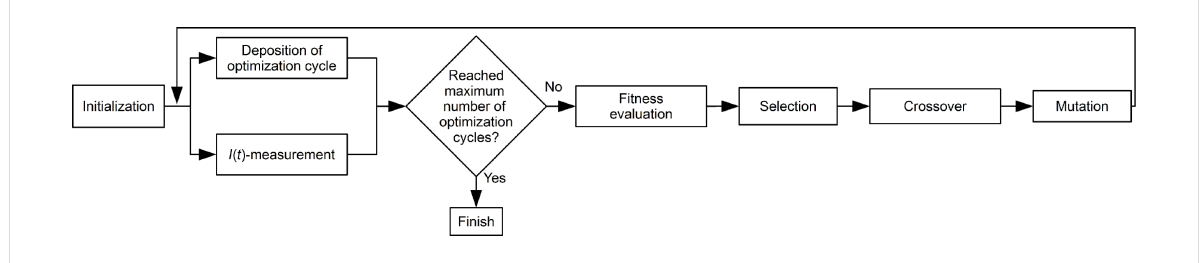
Figure 2: Flow chart of the in situ optimization of conductance of FEBID deposits with a GA. After the initialization of the program, the GA optimizes the conductance of the deposits by using the measured gradient of to evaluate the fitness of the parameter sets used for deposition. Selection, recombination and mutation of parameter sets are carried out after the fitness evaluation to obtain the next optimization cycle with optimized para- meter sets. The process is stopped after the deposition of a pre-defined number of optimization cycles.